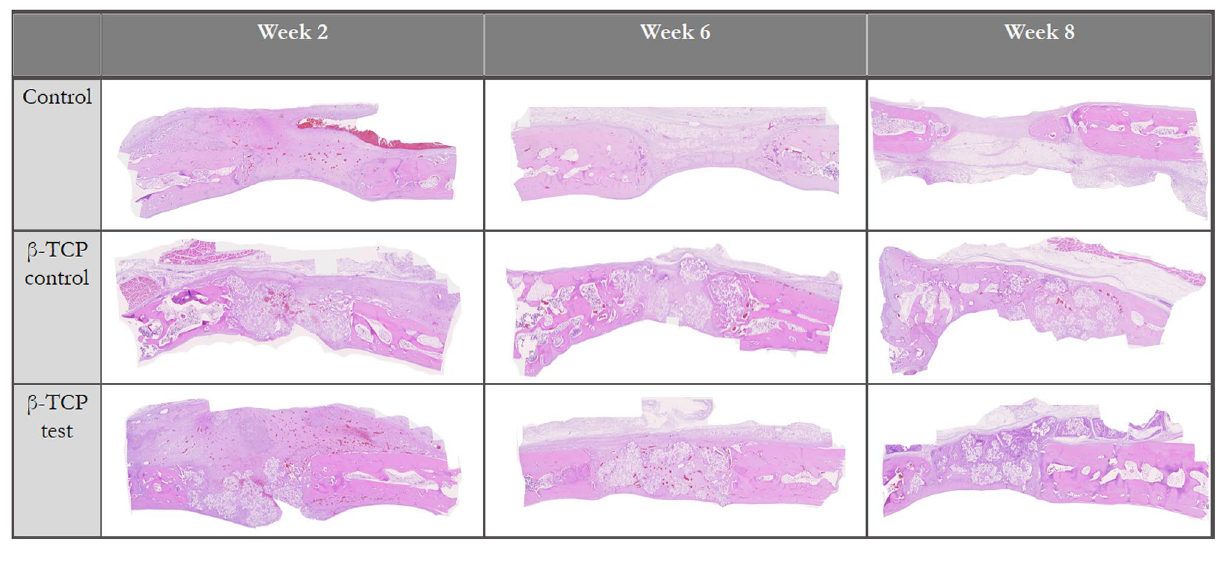
Figure 11. Histologic new bone formation,